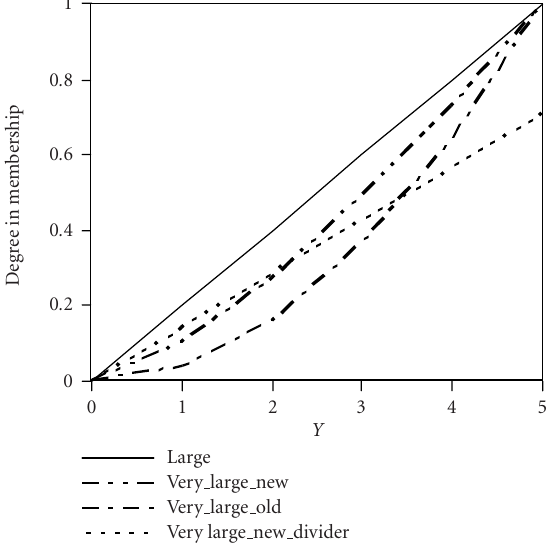
Figure 3.1. Schematic illustration of linguistic hedge